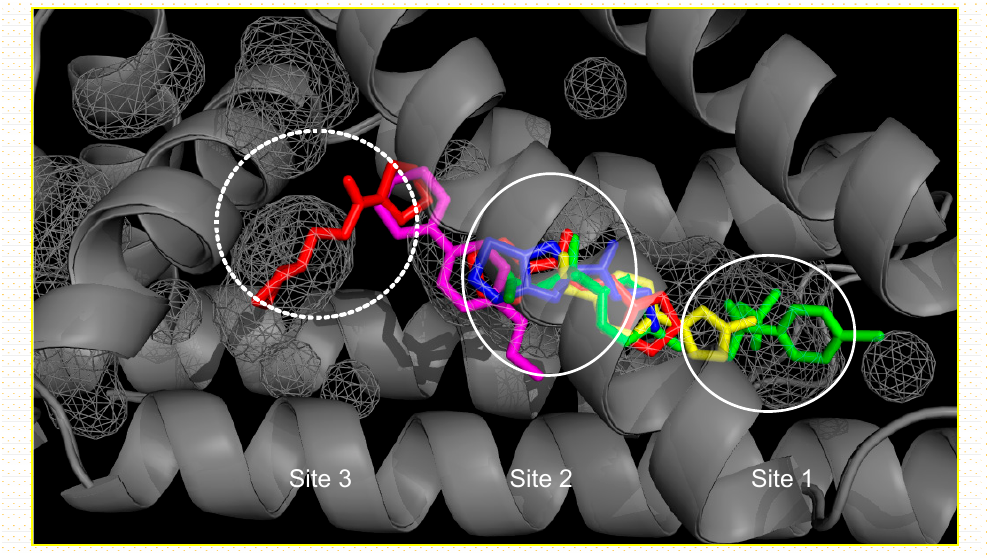
Figure 7. Using structural information for designing better compounds targeting a Mycobacterium tuberculosis target. Overlay of five fragment hits to a protein target, the ethionamide (ETH) receptor, a transcriptional regulator, defined by X-ray analysis. These can then be used to guide the design of a drug-like molecule, by either fragment linking or fragment growth, for example see review by Vitor Mendes and Tom Blundell, 2017 [74].